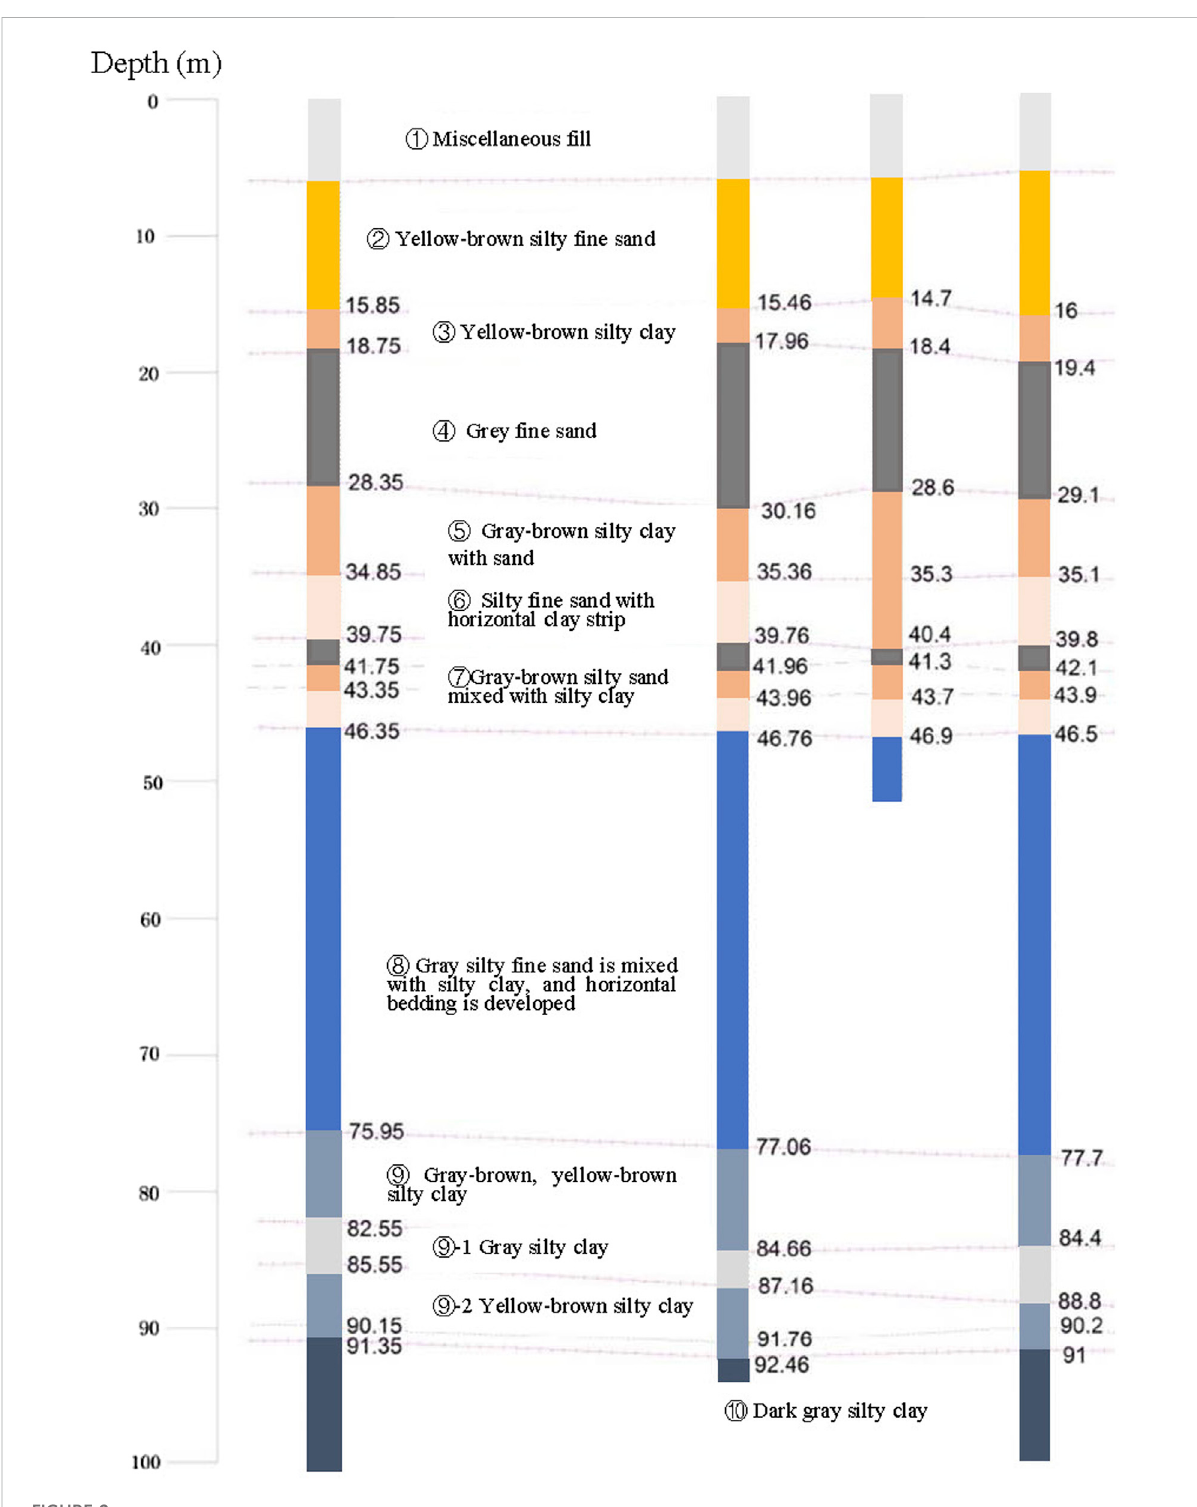
An example borehole joint pro fi le in the Beijing